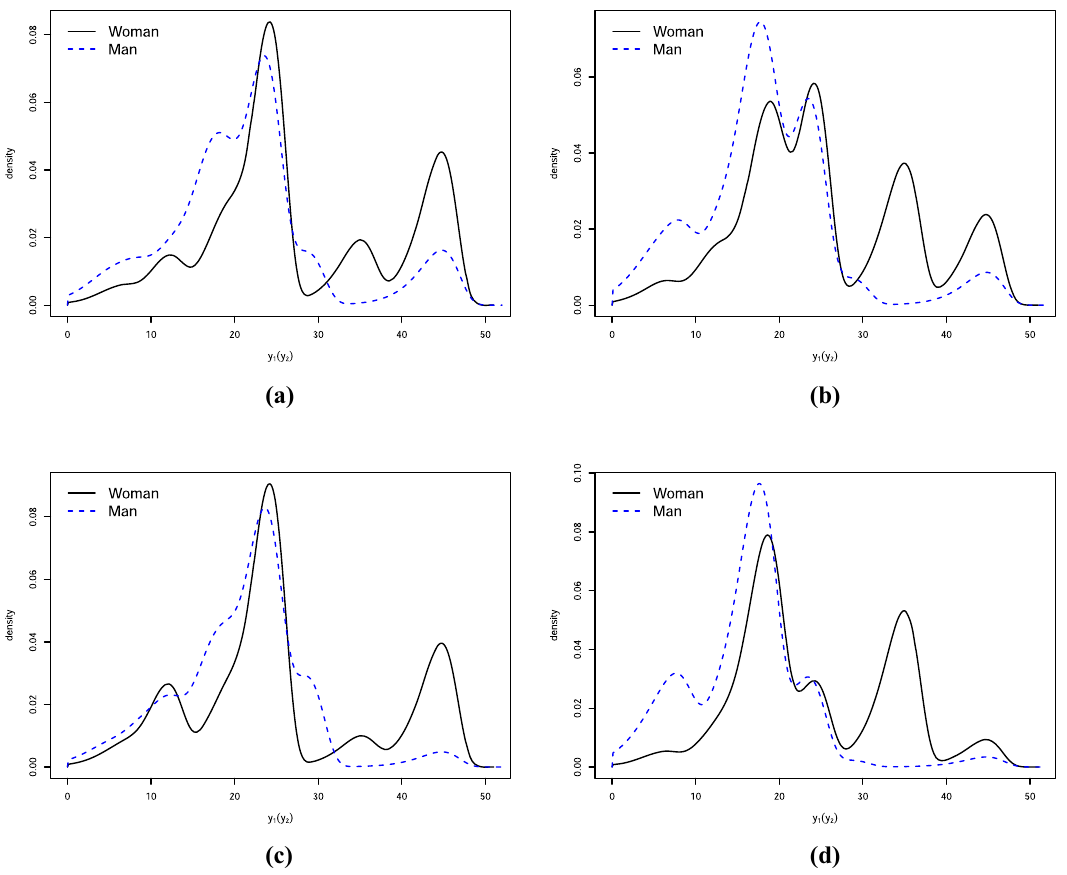
Figure 2: Marginal densities of remaining life times ( in years ) . ( a ) Couple 1. ( b ) Couple 2. ( c ) Couple 3. ( d ) Couple